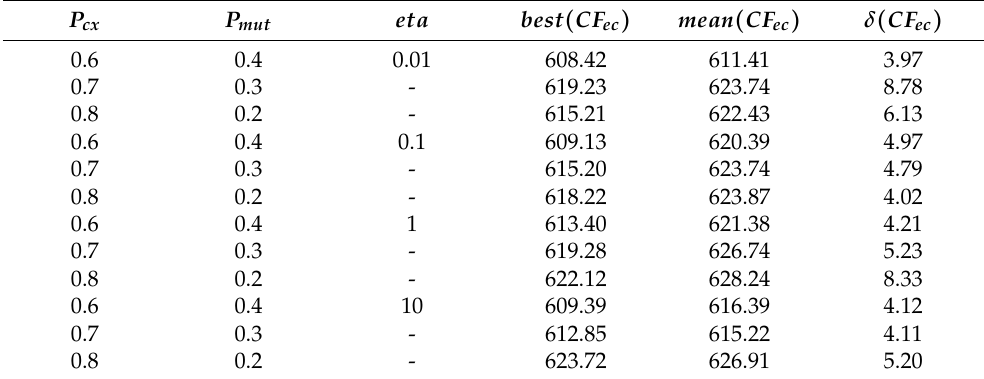
Table 10. Objective function results of the GA approach system with the use of BESS and